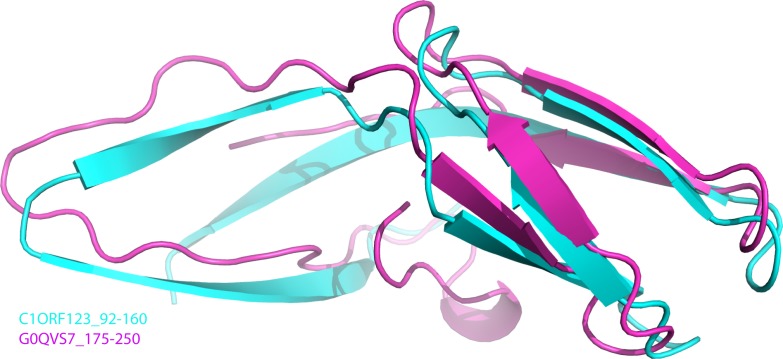
Superposition of C1ORF123 C-terminal half and DUF 866 domain of protein G0QVS7.The human C1ORF123 C-terminal half, residue 92–160 (cyan) and 3D structure was superimposed with DUF866 domain of carbon-nitrogen family protein (residue 175–250), G0QVS7 of Ichthyophthirius multifiliis (magenta) that predicted using Phyre2.